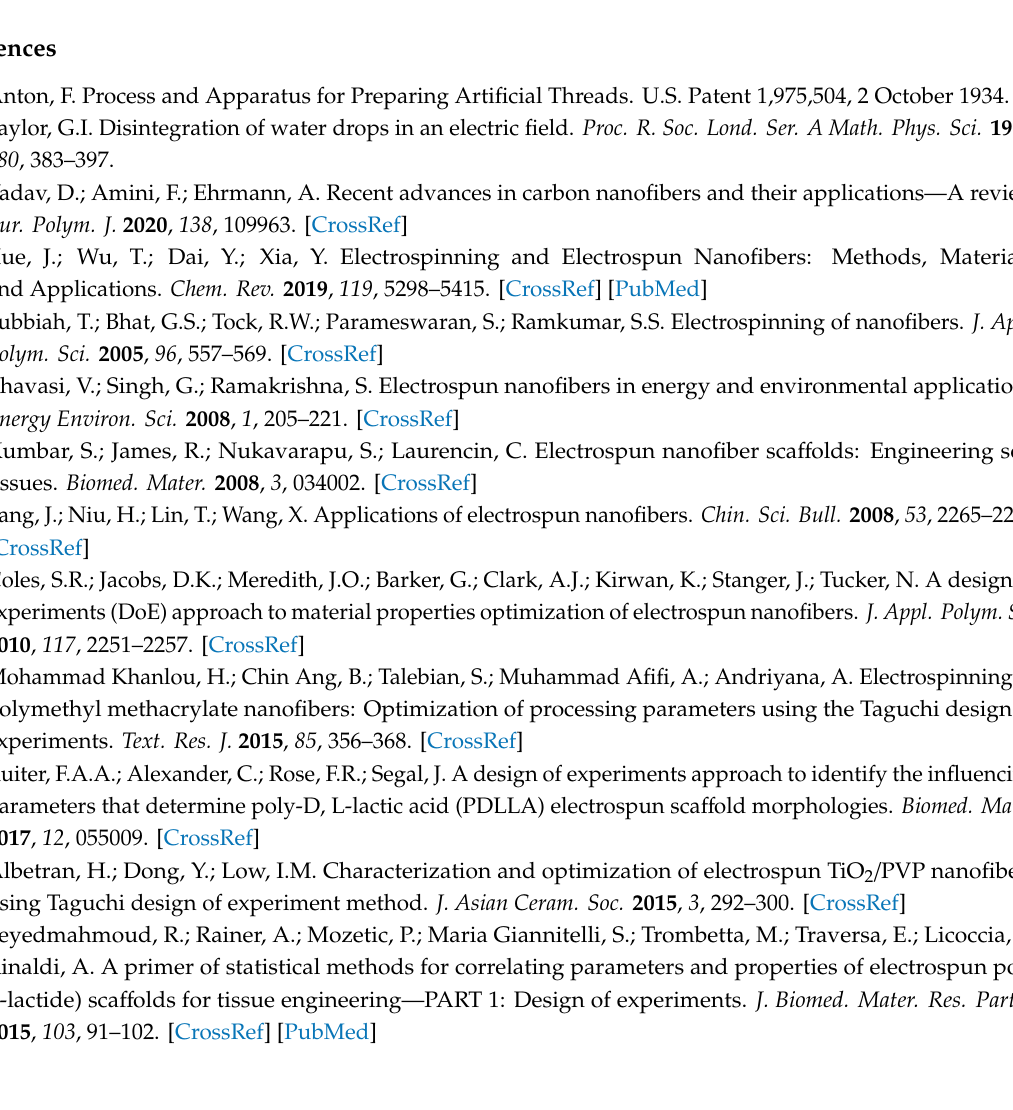
Table S1: Angular measurement of original system; Table S2: Angular measurement of improved system; Table S3: Angular measurement of 8 wt.%–4 V fibers; Table S4: Angular measurement of 8 wt.%–5 V